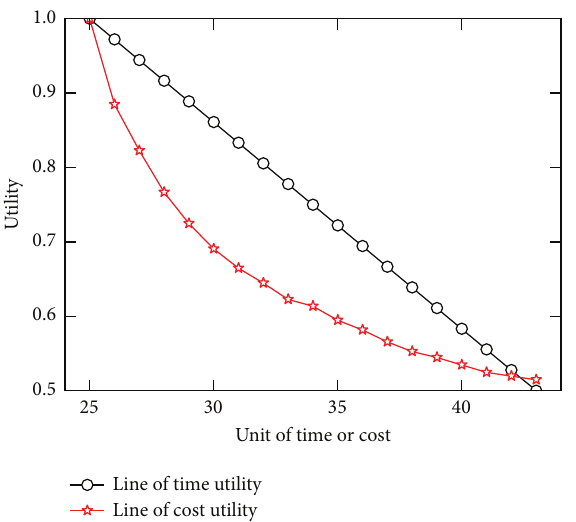
Figure 3: Time and cost utility lines for time sensitive user tasks.